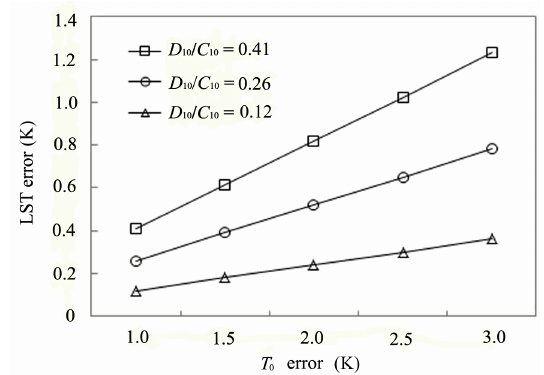
Figure 5. Probable LST estimation error of the IMW algorithm due to the possible error in near surface air temperature